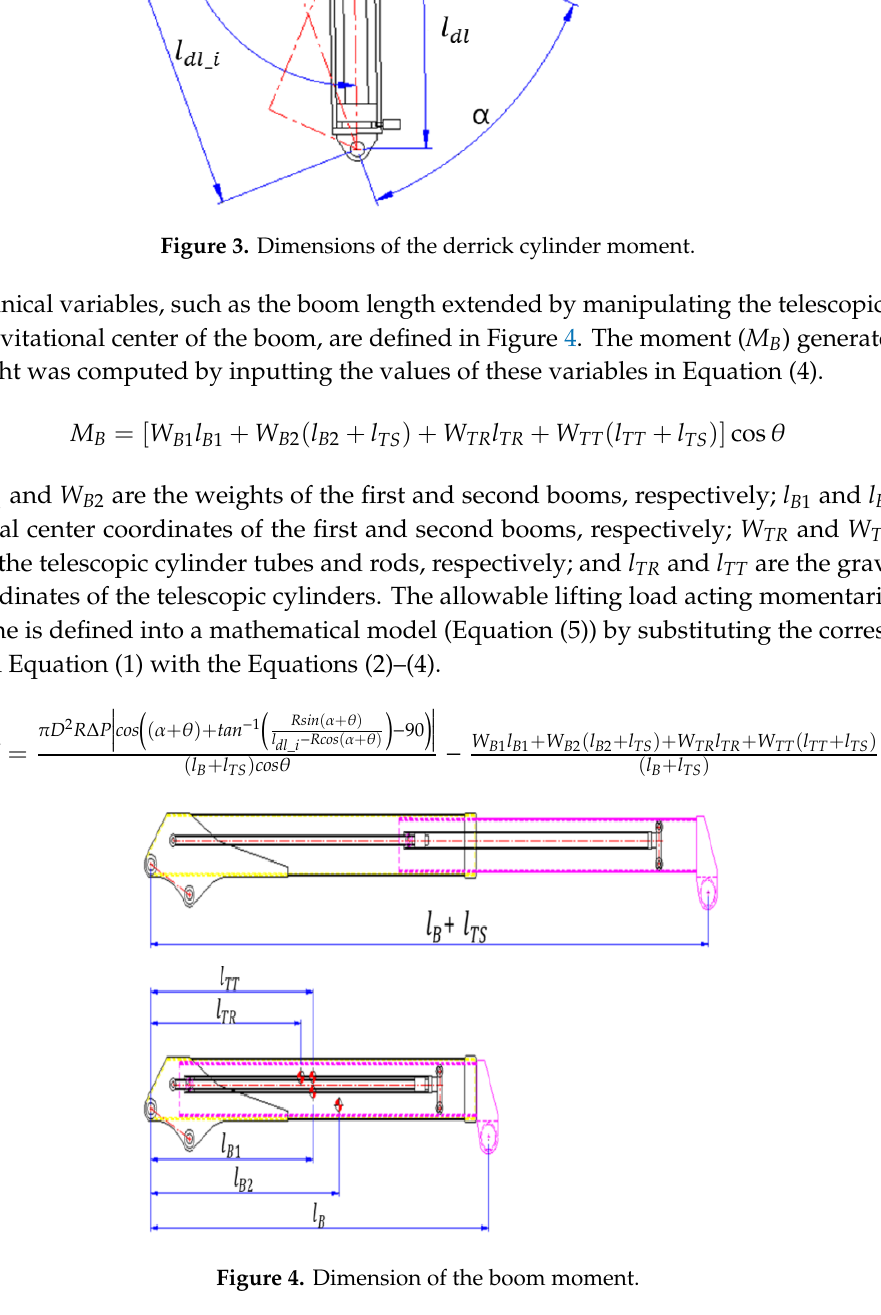
Table 2. Midsize cargo crane (7.5 ton) parameters. Parameter